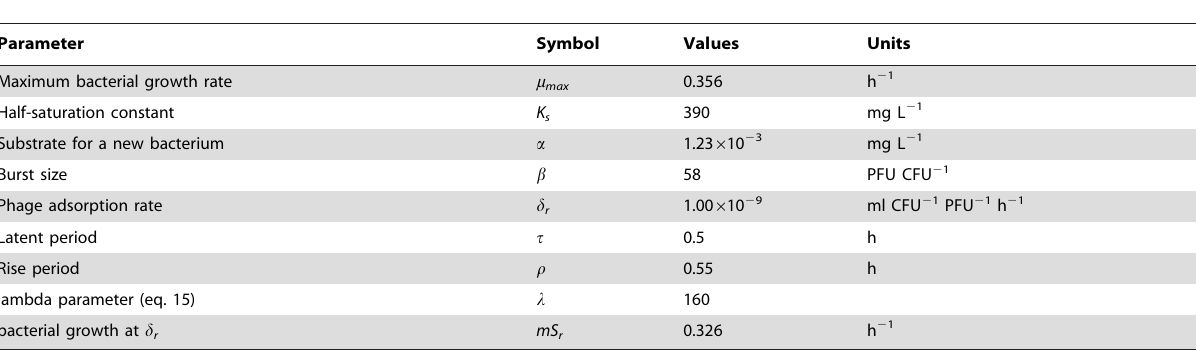
Table 1. Phage-bacteria interaction parameters determined experimentally.